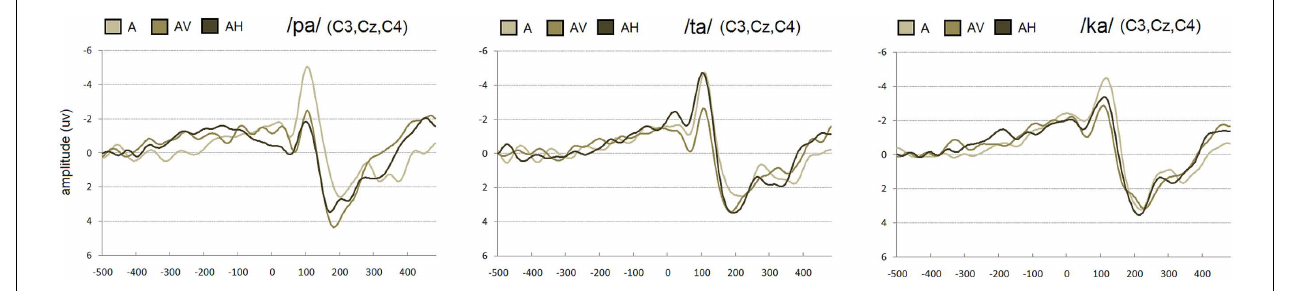
FIGURE 2 | Grand-average of auditory evoked potentials for /pa/, /ta/, and /ka/ syllables averaged over the left (C3), middle (Cz), and right (C4) central electrodes in the auditory, audio-visual, and audio-haptic modalities.